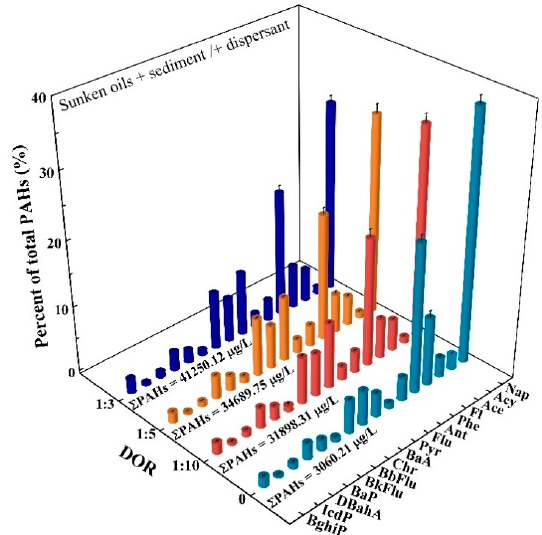
Figure 4. The distribution of PAHs in the sunken oils in the presence of GM-2 and quartz sand.